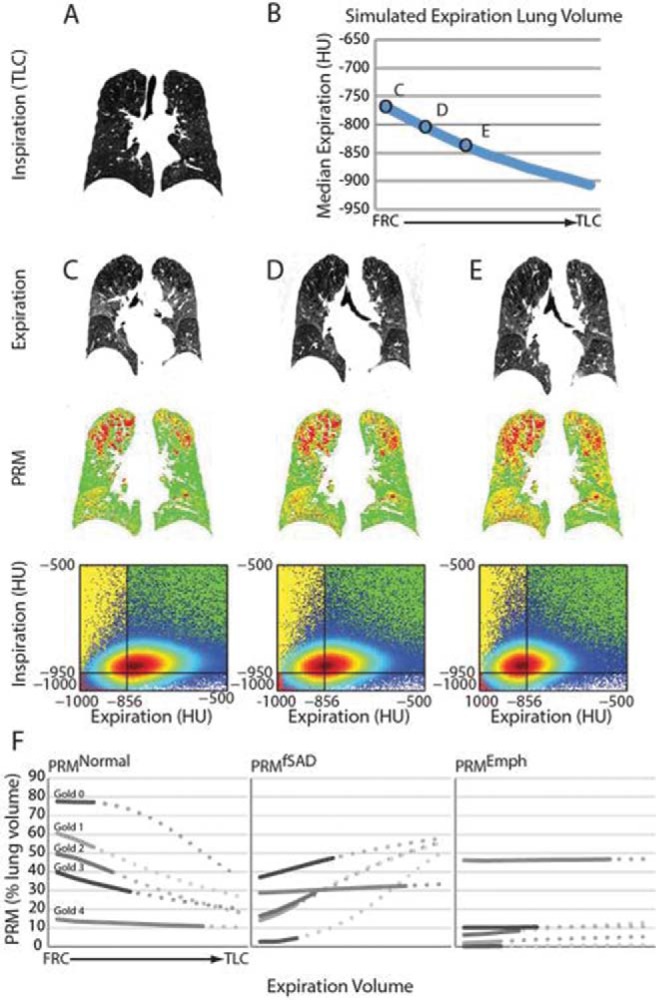
Impact from variability in lung ventilation on PRM. PRM measurements from a patient diagnosed with GOLD stage 2 COPD show the influence of variable expiration resulting from inadequate training or disease. CT data was acquired at full inspiration (A) and relaxed expiration (C) (ie, FRC). Representative CT lung slices, PRMs, and corresponding lung HU joint-density scatter plots are presented at FRC and simulated expiration volumes (C) increased by 20% (D) and 40% (E) from FRC (C). The effective change in median HU values at various expiration volumes are presented in (B) and correspond to a downward shift of the peak in the joint-density plot on the expiration axis, resulting in more tissue classified as PRMfSAD and PRMEmph. The resulting changes in PRMNormal, PRMfSAD, and PRMEmph are shown for 5 sample cases at relaxed expiration (F), where solid lines depict a 0% to 20% change in expiration volumes simulated from FRC to TLC and dotted lines represent further shifts in expiration volumes toward TLC.